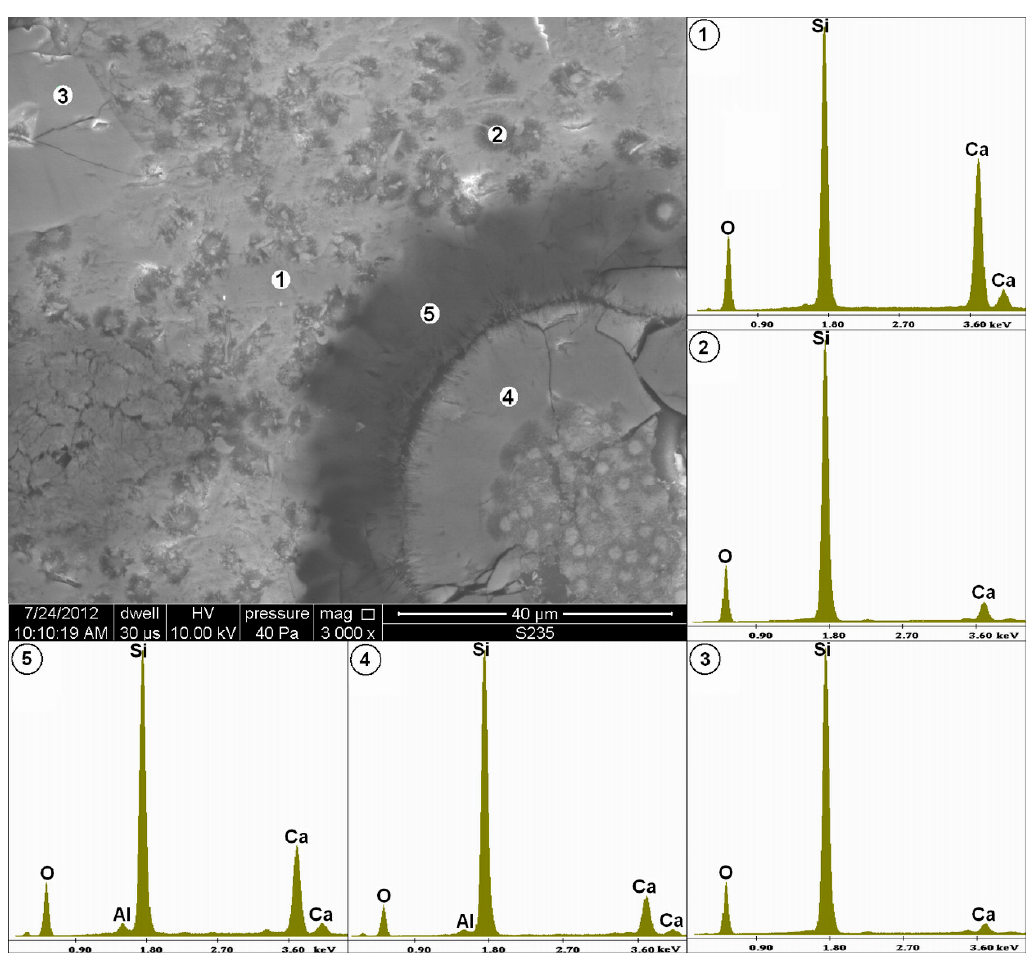
Figure 3. Microstructure of quartz-glaukonitic sandstone with clay-carbonate cement (area marked in Figure 2a), the image at 3000× magnification and with X-ray microanalysis.